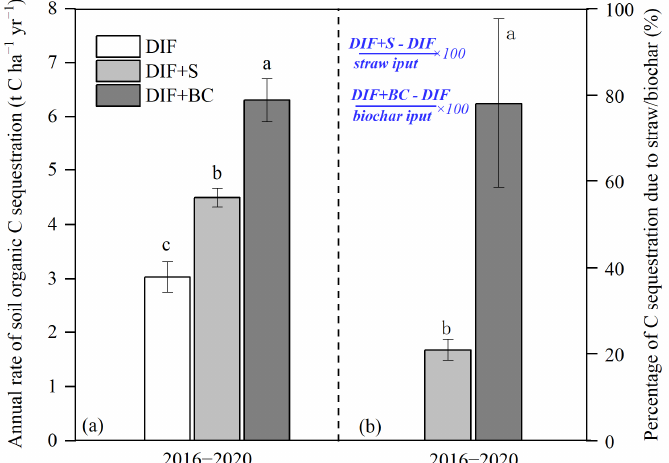
Figure 7. Calculated rates of annual soil C sequestration ( a ) and contribution of straw and biochar additions to total C sequestration between 2016 to 2020 ( b ). Different lowercase letters indicate significant difference amongst treatments ( p < 0.05, n = 3). DIF: drip fertigation (DIF); DIF+S: drip fertigation with straw incorporation; DIF+BC: drip fertigation with biochar incorporation. Error bars represent the standard error ( n =